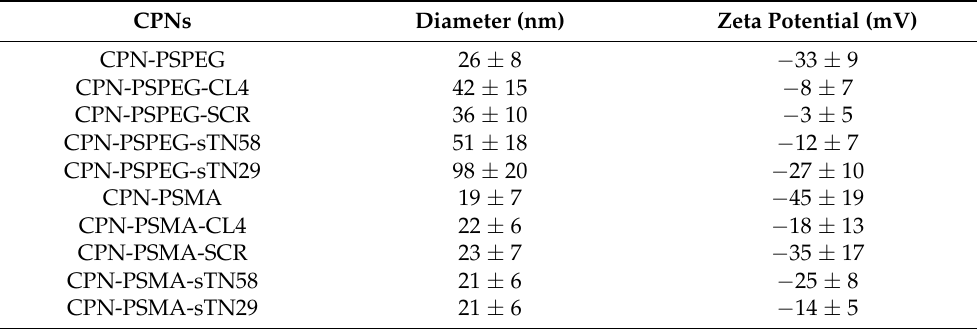
Table 1. Hydrodynamic diameter and zeta potential of different aptamer-decorated CPNs and nonconjugated